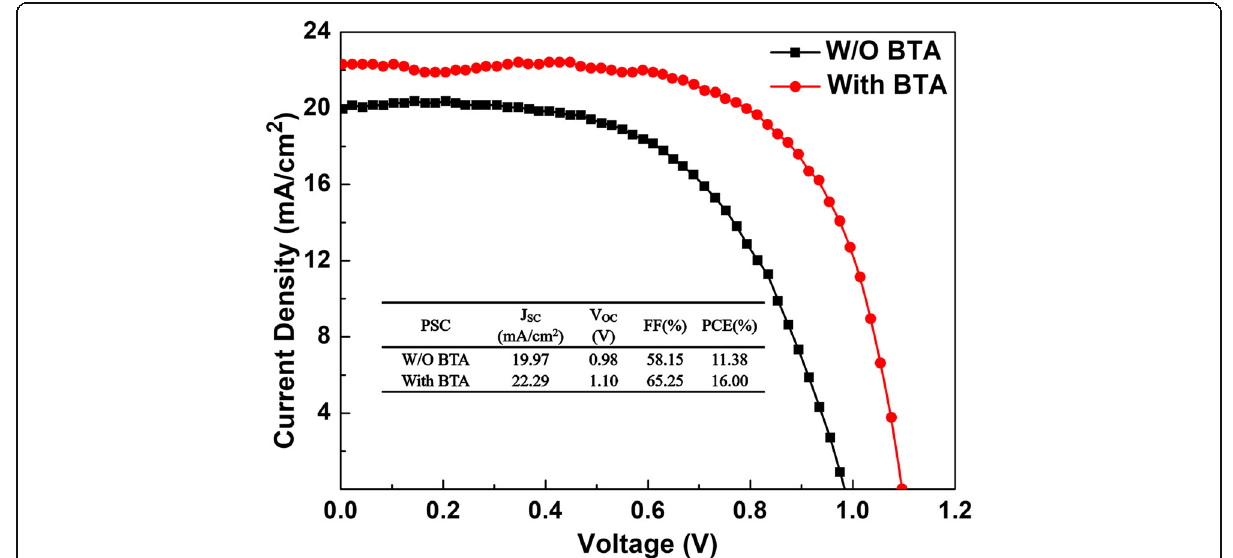
Fig. 6 J-V characteristics of the PSCs fabricated with and without BTA additive in ambient air with 25% RH under AM 1.5G one sun (100 mW cm − 2 ) illumination, the inset is the detailed photovoltaic